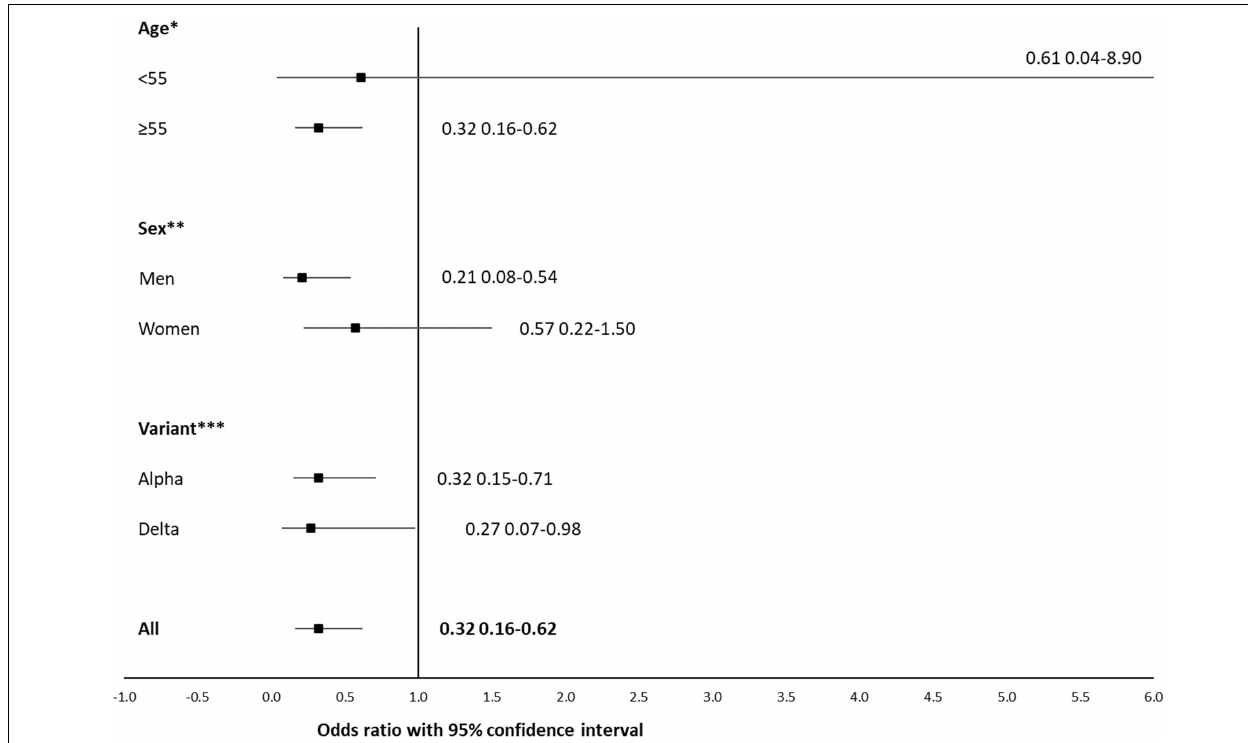
FIGURE 3 | Forest plot showing the influence of age, sex and variant on association between death and vaccination (partially or fully vaccinated). Stratified multivariate logistic regression ( n = 11,624 ∗ ). Odds ratios and 95% confidence intervals are indicated for all comparisons. Only patients with the Alpha/20I or Delta/21A variants are included. ∗ Multivariate model is stratified on age and adjusted on sex and variant. ∗∗ Multivariate model is stratified on sex and adjusted on age and variant. ∗∗∗ Multivariate model is stratified on variant and adjusted on age and sex.